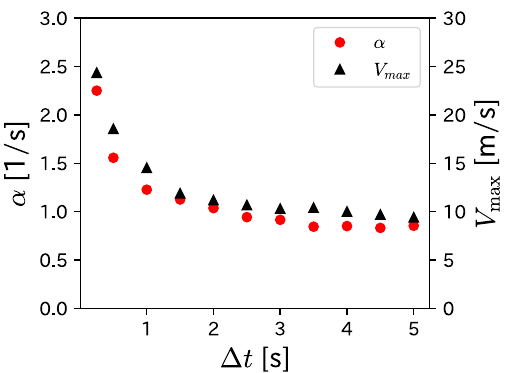
Figure 7. (cid:31) t dependence of kinetic parameters, α and V max